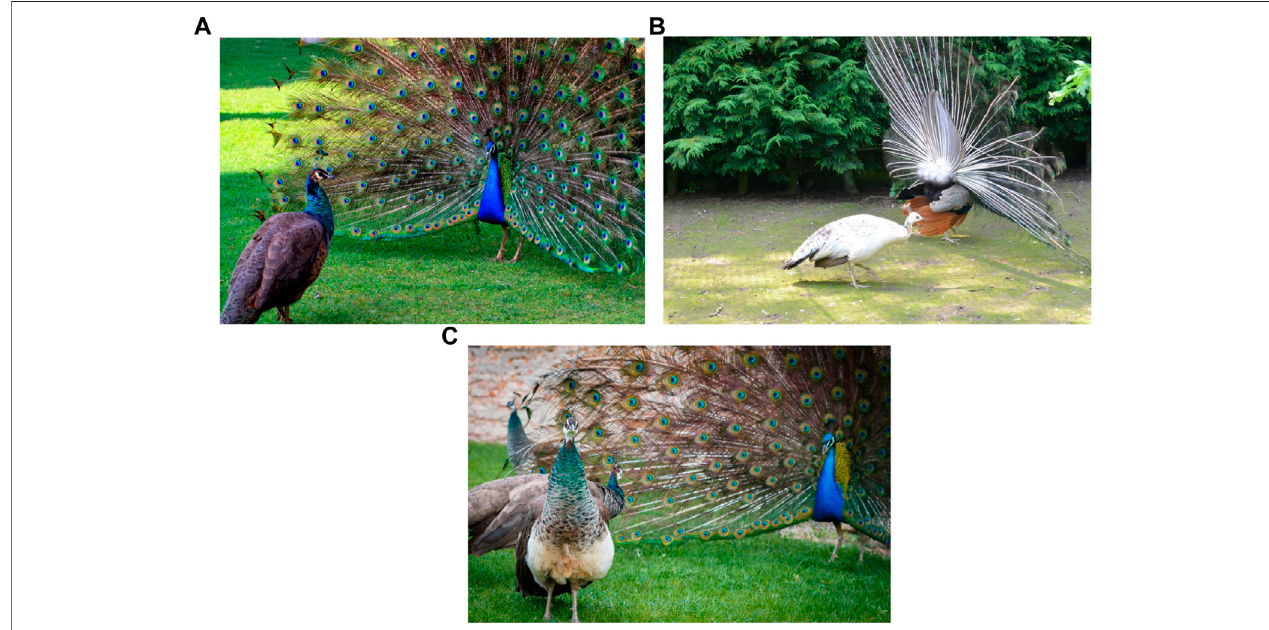
FIGURE 2 | Courtship behaviors of peacocks: (A) tail spreading and displaying; (B) rotating; (C) fl apping feathers.